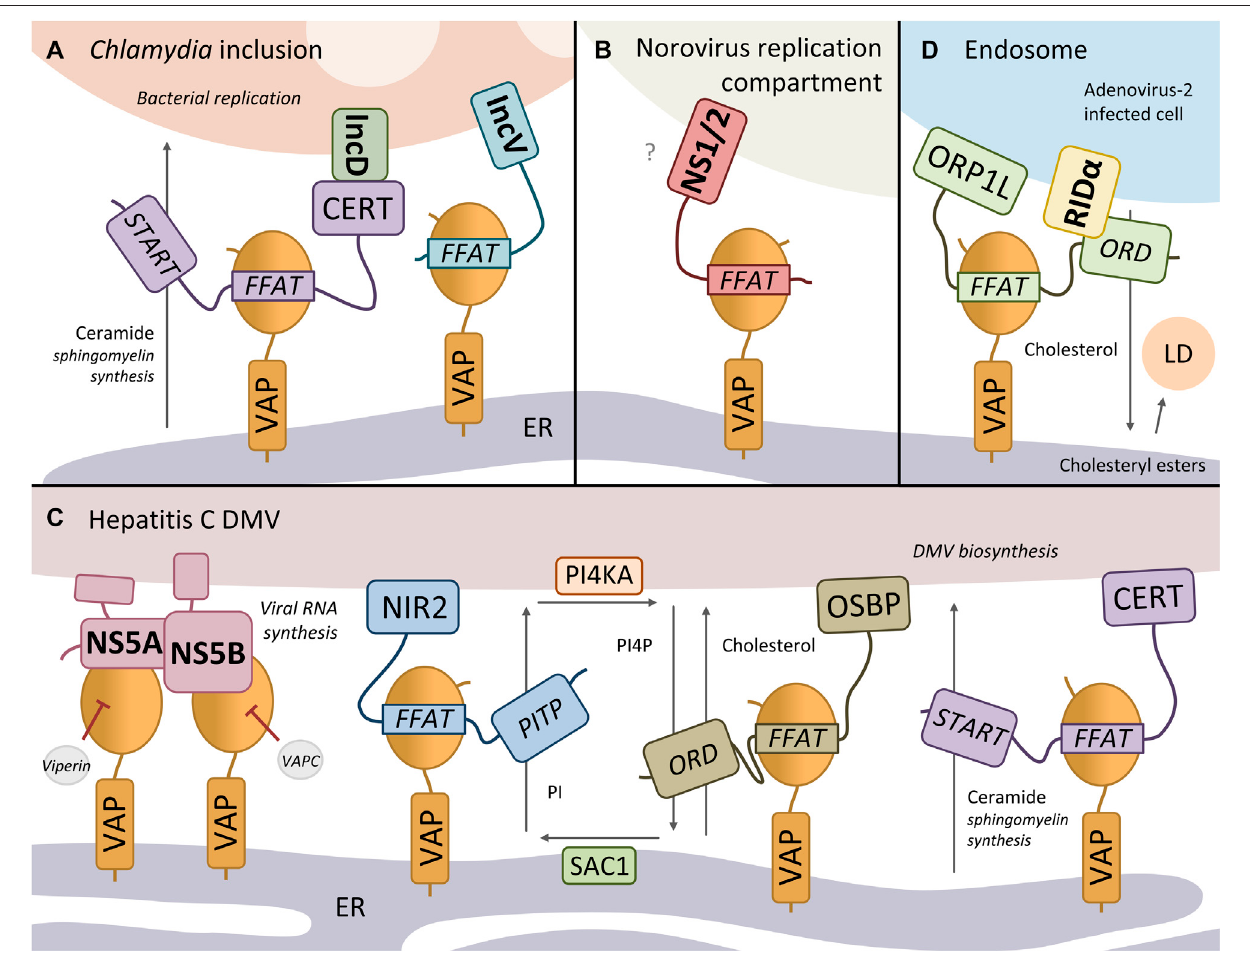
FIGURE 2 | VAP hijacking by bacteria and viruses. (A) The Chlamydia integral inclusion membrane proteins IncV and IncD are both found in a complex with VAP. While IncV binds VAP directly via a FFAT motif, IncD interacts with VAP-interactor CERT, forming an IncD-CERT-VAP complex at inclusion-ER contact sites. CERT may facilitate ceramide transfer from the ER to the inclusion membrane for the synthesis of sphingomyelin, important for C. trachomatis replication. (B) The murine norovirus protein NS1/2 binds VAP via its FFAT motif, critical for viral replication. The NS1/2-VAP may tether the replication membrane to the ER. (C) VAP binds to the hepatitis Cvirusproteins NS5A and NS5B, importantfor viral RNAreplication at double-membranevesicles (DMVs). VAP supportsthe viral replication by recruiting host NIR2, OSBP, CERT to the DMV-ER contact site. NIR2 transfers PI from the ER membrane to the DMV membrane, where it is converted to PI4P by the PI4P-kinase PI4KA. The PI4P is then exchanged for cholesterol from the ER by OSBP. The PI4P-phosphatase SAC1 converts PI4P back to PI. CERT transports ceramide from the ERtotheDMV, where itisconverted tosphingomyelin, important forthebiosynthesis ofDMVs. (D) TheAdenovirus-2protein RID α directly interacts and recruitsORP1L to maturing early endosomes to form endosome-ER MCS via ORP1L-VAP binding, which facilitates the transport of cholesterol from endosomes to the ER. Here, cholesterol is converted into cholesteryl esters, which are stored in lipid droplets (LD). Bacterial/viral proteins are indicated in bold.